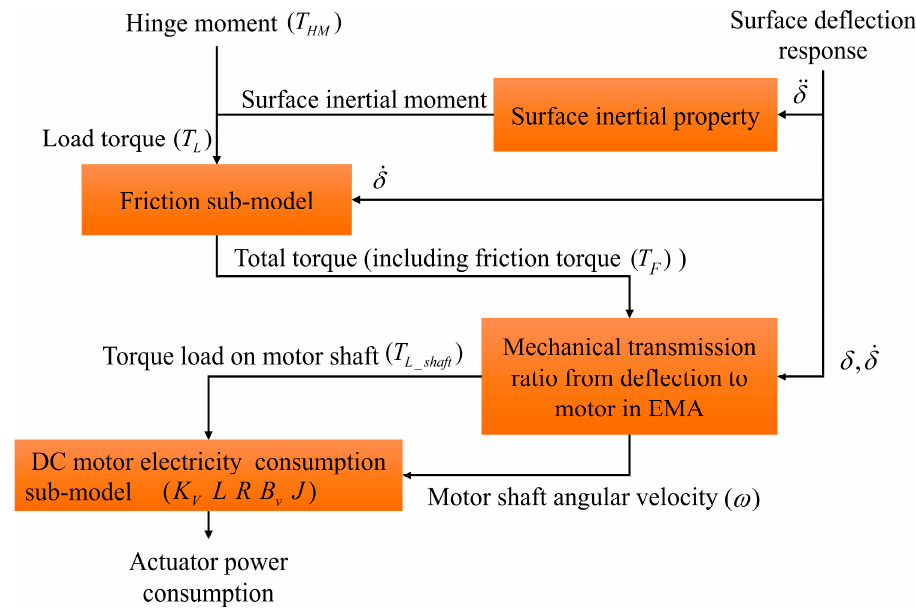
Figure 4. Schematic showing the power consumption calculation in the EMA Power Model.